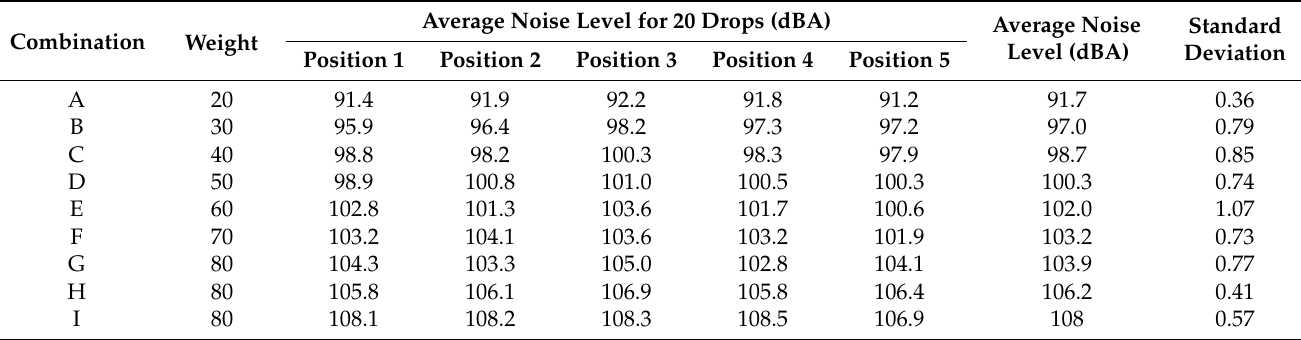
Table A1. Detailed data of four selected groups (clean and jerk).